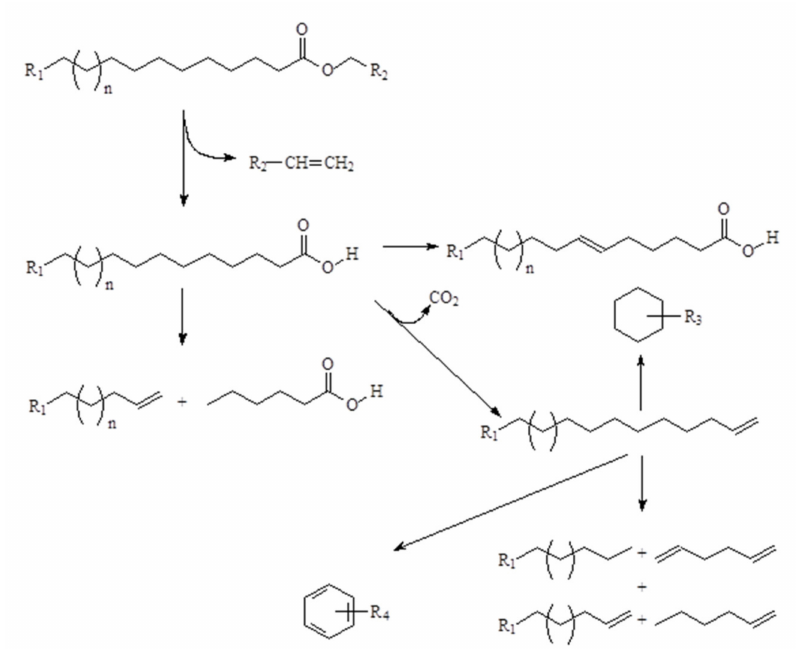
Figure 5. Radical degradative route of fatty acids under pyrolytic